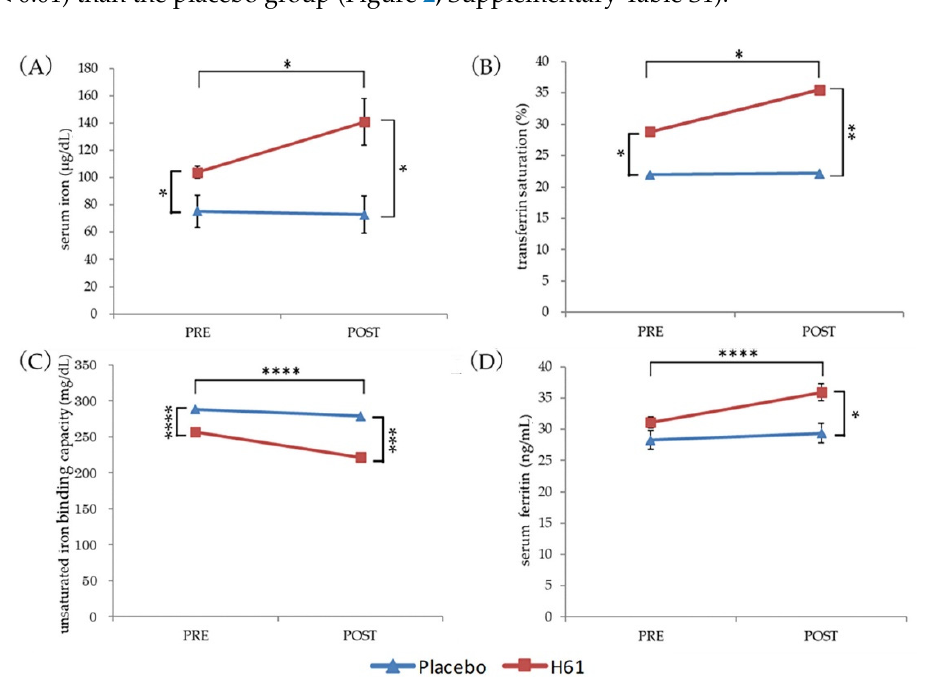
Table 2. Changes in the estimated daily intake of iron and vitamin C. EAR